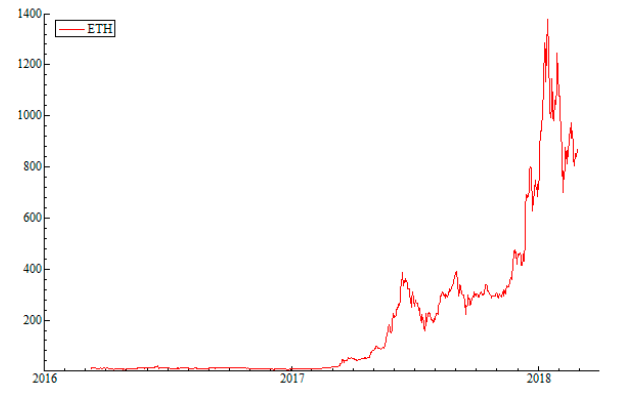
Figure 1. Time Series Plots of Bitcoin price and return. ( A ) Presents the plot historical plot of daily closing prices for Bitcoin between January 1, 2014 and February 28, 2018. ( B ) Presents the daily returns for Bitcoin for the same time period. The data is obtained from Bitfinex.